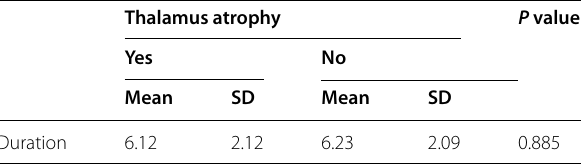
Table 12 Relation between the duration and presence of thalamic atrophy